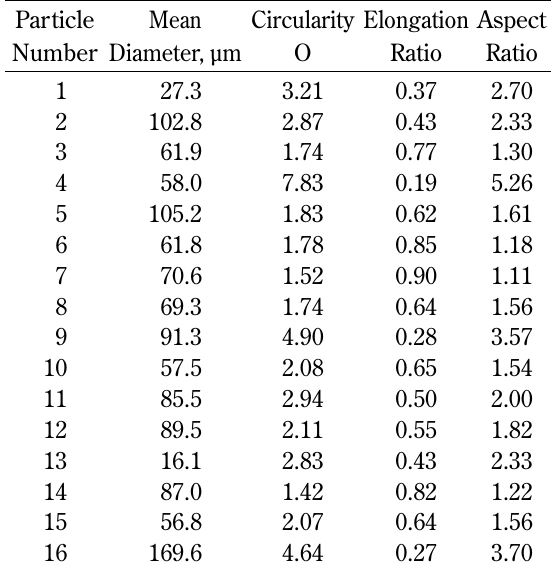
Table 1 . Size and Shape Parameters for UF 200x400 Mesh Size Cut Shown in Fig. 1